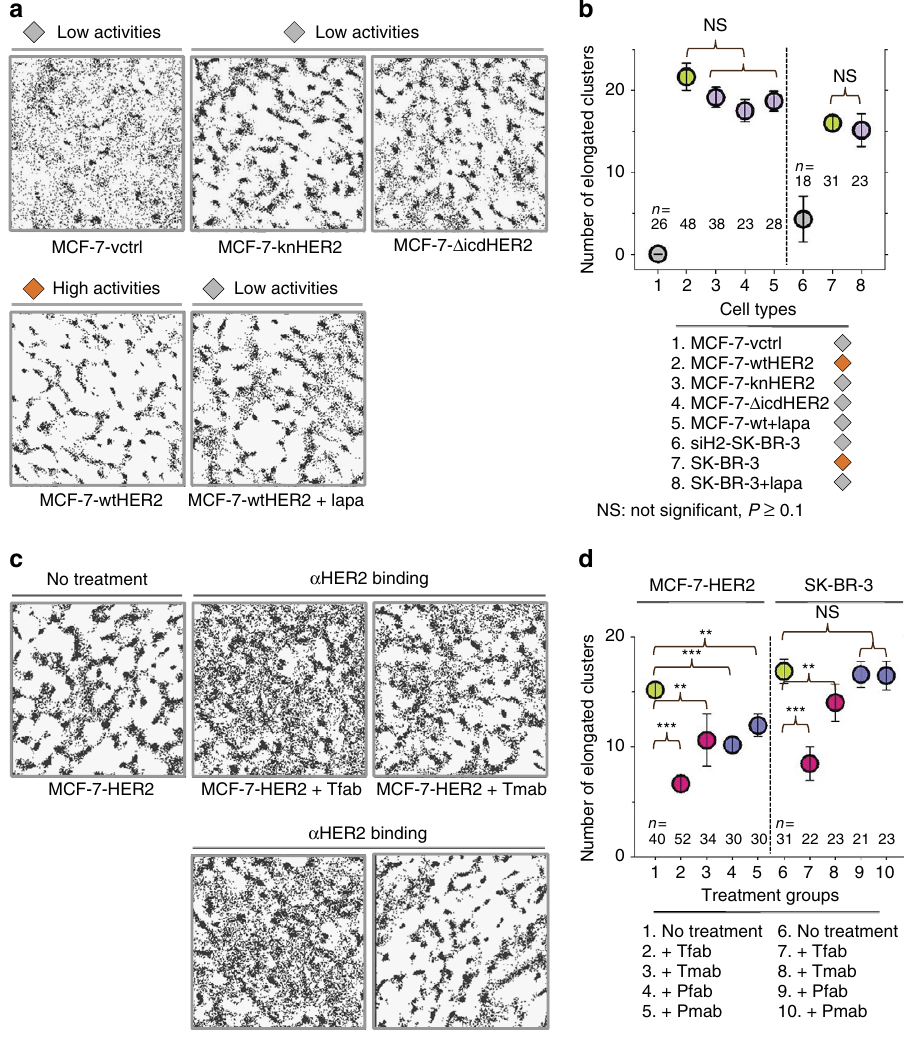
Figure 3 | Membrane deformation by HER2 overexpression is independent of HER2 signaling. ( a ) Elongated HER2 clusters are observed in high expressers of signalling-incompetent HER2 mutants, MCF-7-knHER2 and MCF-7- D icdHER2, similar to those in wtHER2 high expressers (orange diamond). Clustered HER2 location patterns shown in MCF-7-wtHER2 (orange diamond) were also largely insensitive to 30 0 kinase inhibitor (lapatinib) treatment (grey diamond). The occurrence of the elongated HER2 clusters in MCF-7-vctrl (grey diamond) is significantly less. ( b ) Numbers of elongated clusters quantified by cluster analysis in MCF-7 and SK-BR-3 cell variants, indicate that regardless of HER2 signalling activities, 3 þ HER2 expression results in significantly greater FLS than low expression (MCF-7-vctrl and siH2-SK-BR-3 cells). Light grey/green/purple circles: low/high/high HER2 levels and low/ high/low HER2 signalling activities. ( c ) Effects of 1 day treatments of MCF-7-HER2 cells with trastuzumab fab (Tfab), trastuzumab (Tmab), pertuzumab fab (Pfab) and pertuzumab (Pmab) on elongated cluster patterns of HER2. Tfab and Pfab treatments noticeably down-modulated clustered HER2 patterns in MCF-7-HER2. ( d ) Comparison of the numbers of elongated clusters in MCF-7-HER2 and SK-BR-3 cells untreated/treated with Tfab, Tmab, Pfab and Pmab. Green/magenta/blue circles: untreated/Tfab and Tmab treatments/Pfab and Pmab treatments. *** P value o 10 (cid:3) 6 and ** P value o 10 (cid:3) 4 by two-sided, unpaired Welch’s t -test. All values are mean ±